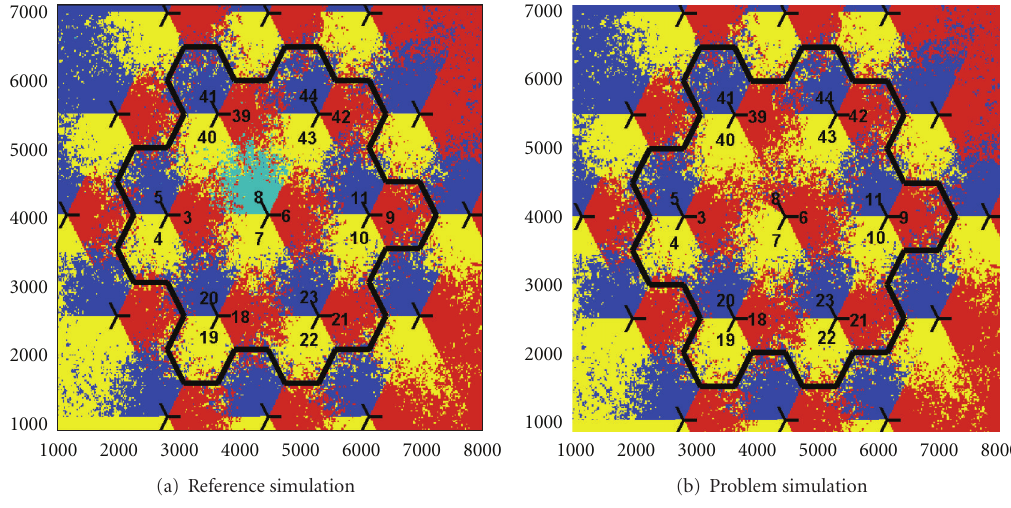
Figure 4: Network dominance areas.